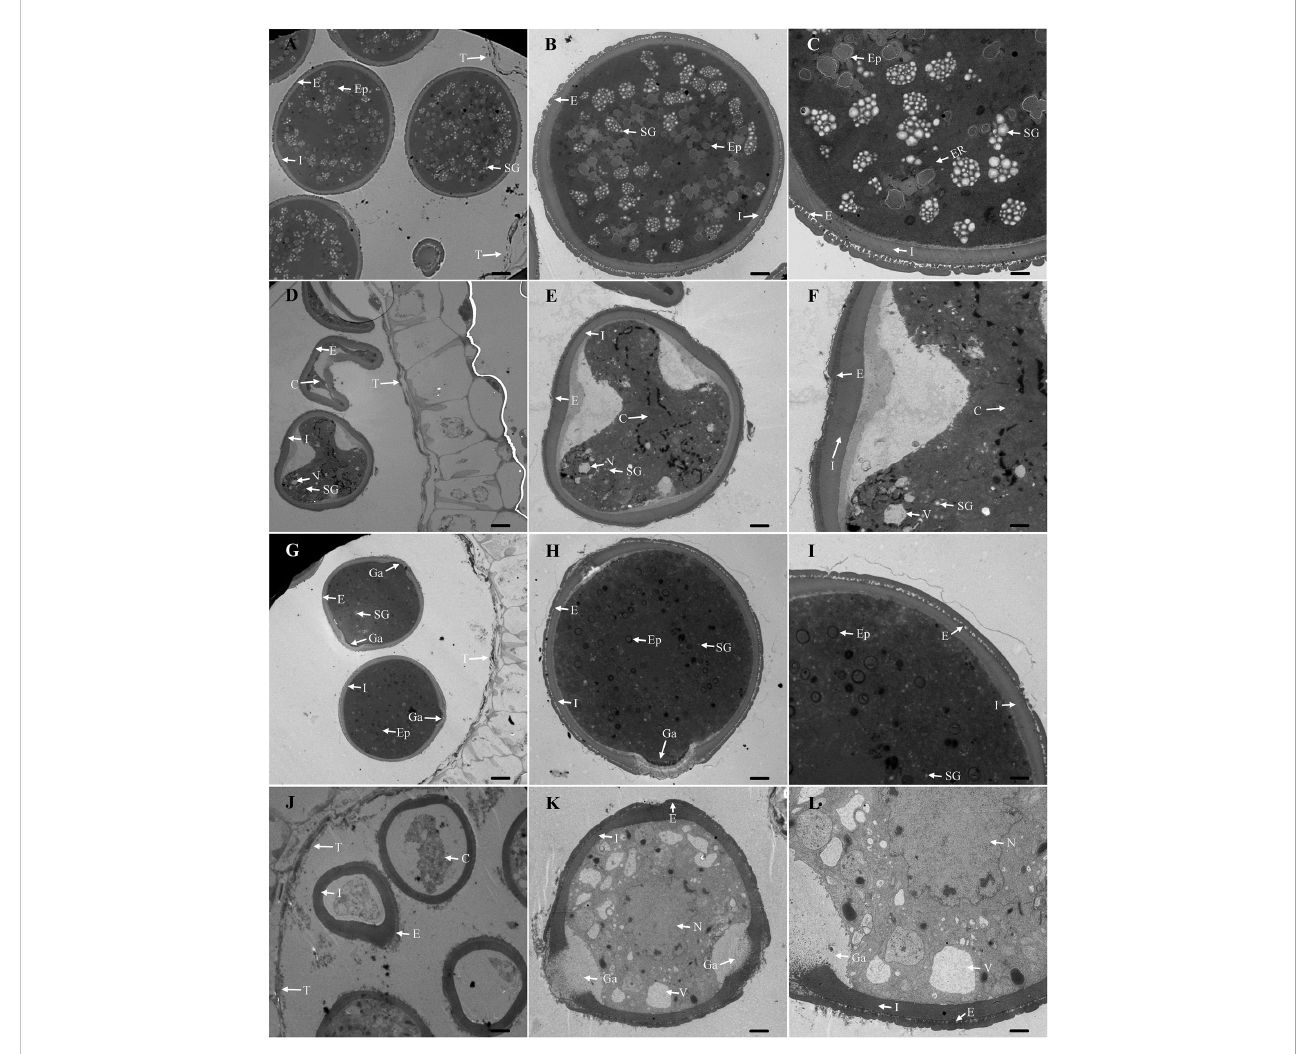
FIGURE 1 Transmission electron microscopy (TEM) images of anthers from the cytoplasmic male sterility (CMS) line W931A and its maintainer line, W931B. (A – C) : Binucleate pollen (BP) grain from the maintainer line W931B at the BP stage. (D – F): BP grain from the male sterile line W931A at the BP stage. (G – I) : Mature pollen grain from the maintainer line W931B. (J – L) : Mature pollen grain from the male sterile line W931A. C, content; E, exine; Ep, elaioplast; ER, endoplasmic reticulum; Ga, germinal aperture; I, intine; N, nucleolus; SG, starch granule; T, tapetum; V, vacuole. Scale bars = 10 m m (A, D, G, J) , 5 m m (B, E, H, K) , and 2 m m (C, F, I, L)